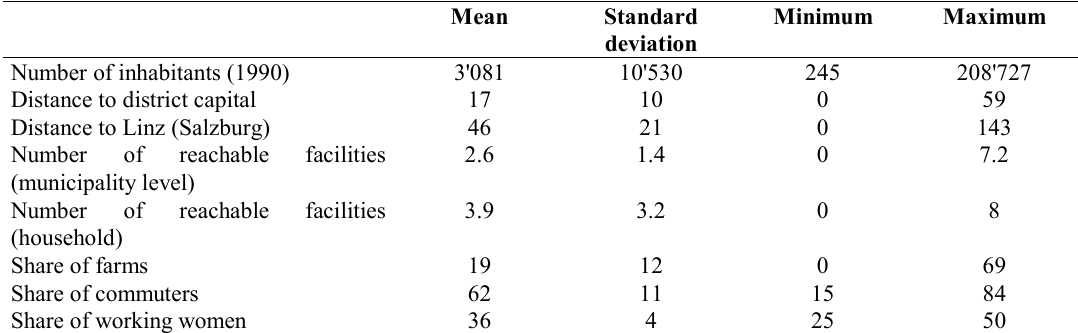
Table 1. Descriptive statistics for the municipalities of Upper Austria (445